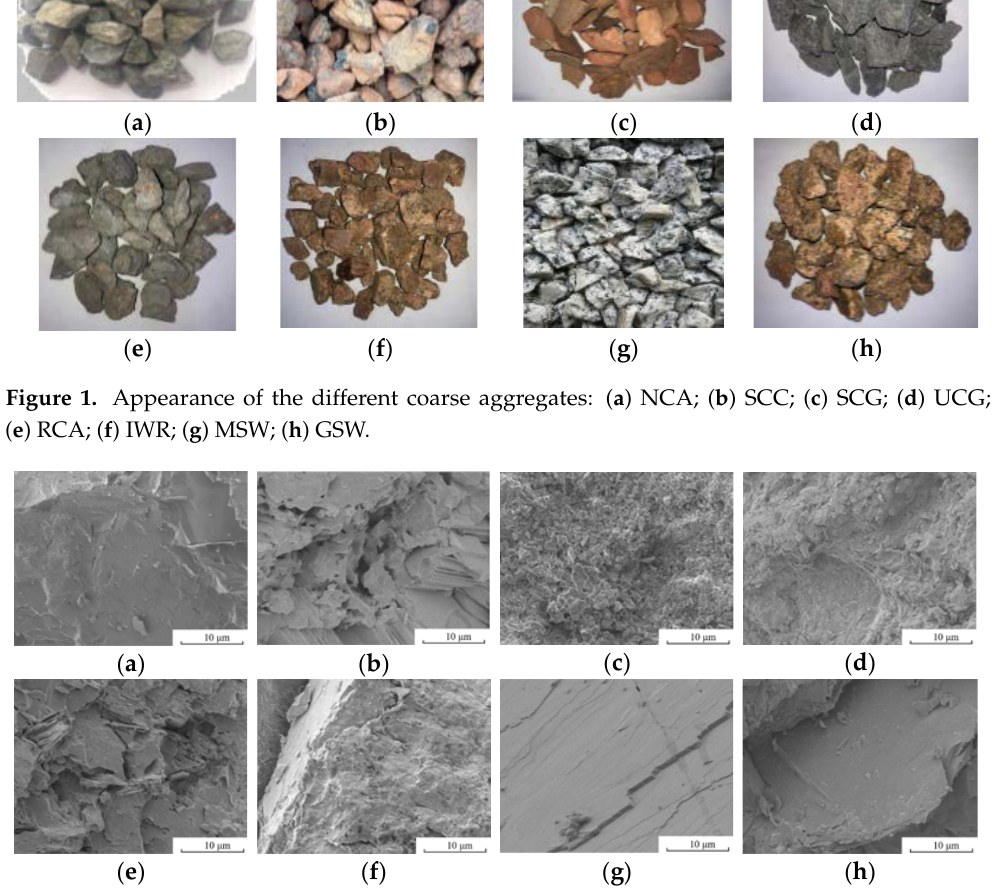
Figure 2. Microstructure of the different coarse aggregates: ( a ) NCA; ( b ) SCC; ( c ) SCG; ( d ) UCG; ( e ) RCA; ( f ) IWR; ( g ) MSW; ( h ) GSW. Table 1. Physical and mechanical properties of the different coarse aggregates.